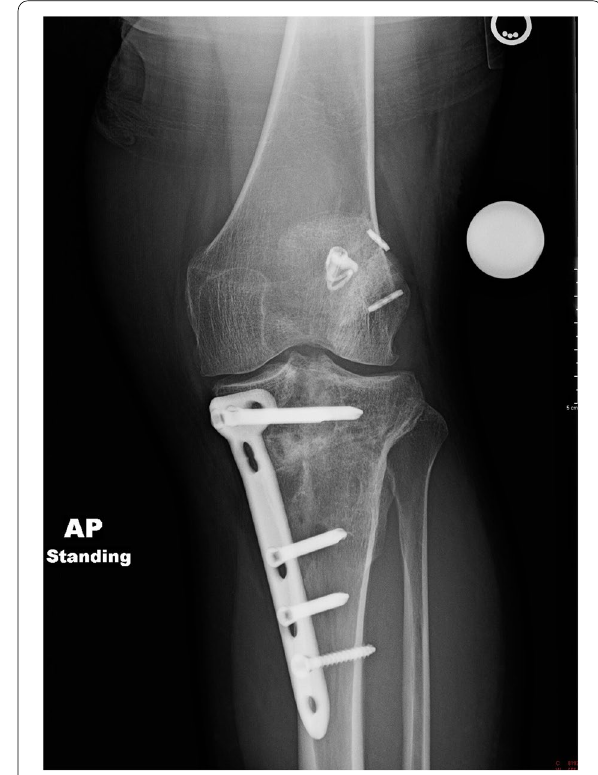
Fig. 7 An AP radiograph showing the healed osteotomy